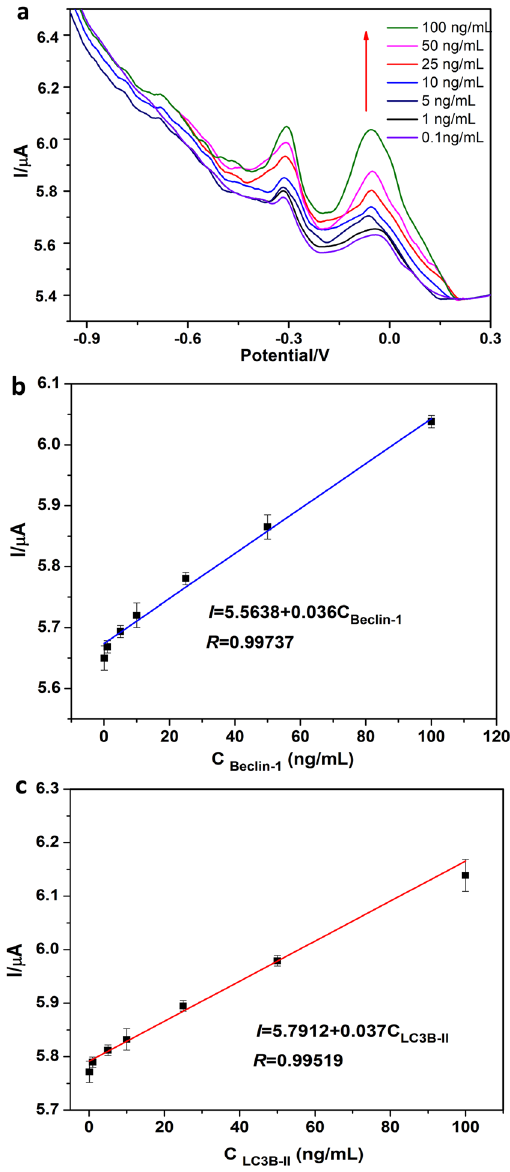
Figure 5. DPV responses of the proposed immunosensor after incubation with different concentrations of LC3B-II and Beclin-1 ( a ); Calibration curves of the multiplexed immunoassay toward Beclin-1 ( b ) and LC3B-II ( c ) in PBS (pH 7.5).